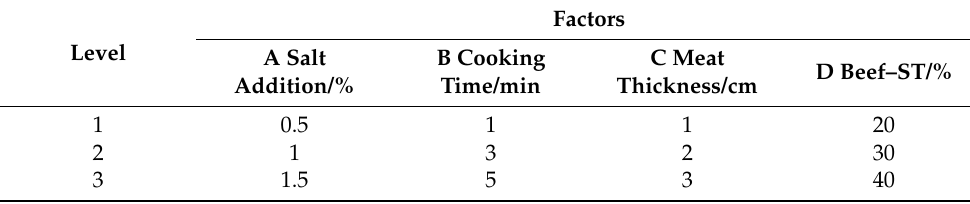
Table 1. Factor level of orthogonal